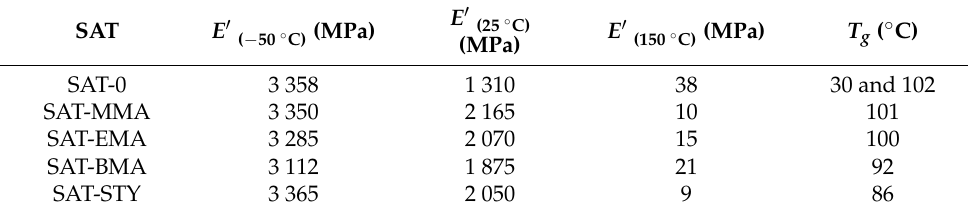
Table 6. Storage modulus (E (cid:48) ) and the glass transition temperature ( T g ) of cured SATs.